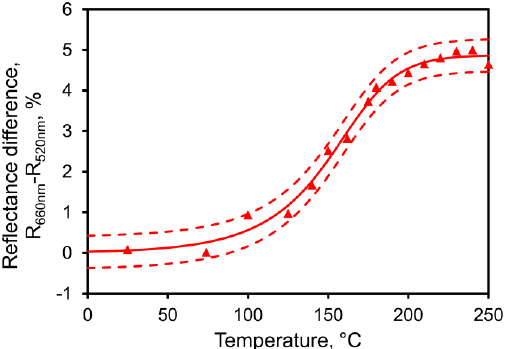
Figure 3. Development of an optical absorption edge in a thin film of gold sponge determined in situ while ramped at 6 °C·min −1 . The sponge coarsens quite rapidly above 100 °C. A sigmoidal model (Richard’s model, solid line) and 95% confidence interval (dashed lines) have been fitted to guide the eye. Sample deposited as 76 at.% Al and de-alloyed in 0.2 M